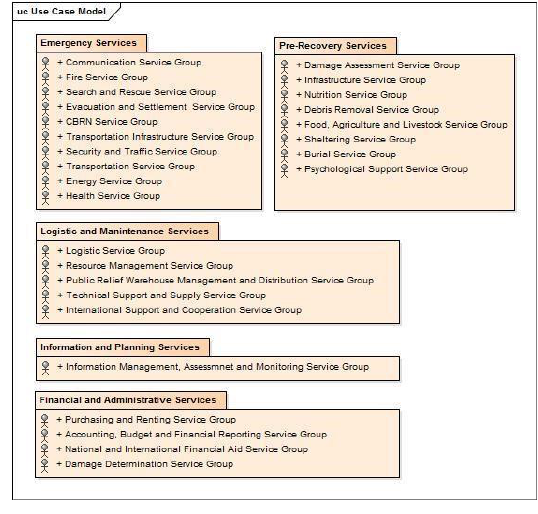
Figure 1: National service groups in